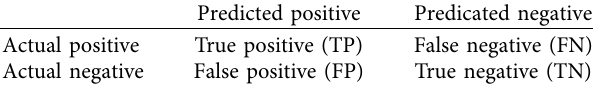
Table 4: Confusion matrix.